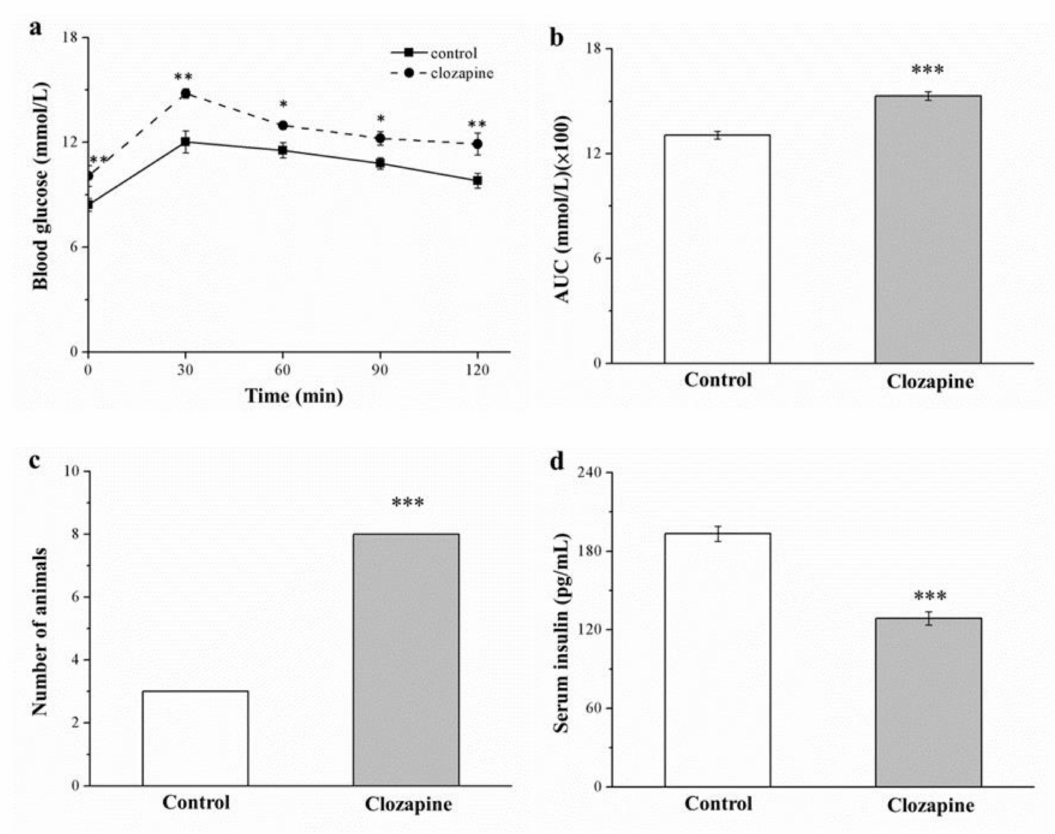
Figure 6. ( a ) Intraperitoneal tolerance to 1 g of glucose per kilogram of body weight; ( b ) area under curve at 120 min following injection of glucose; ( c ) number of mice with glucose intolerance (Fisher’s exact test); and ( d ) serum insulin levels in clozapine (receiving 2 mg/kg/day) and control groups. Data are mean ± standard deviation ( n = 10). * p < 0.05, ** p < 0.01, *** p <